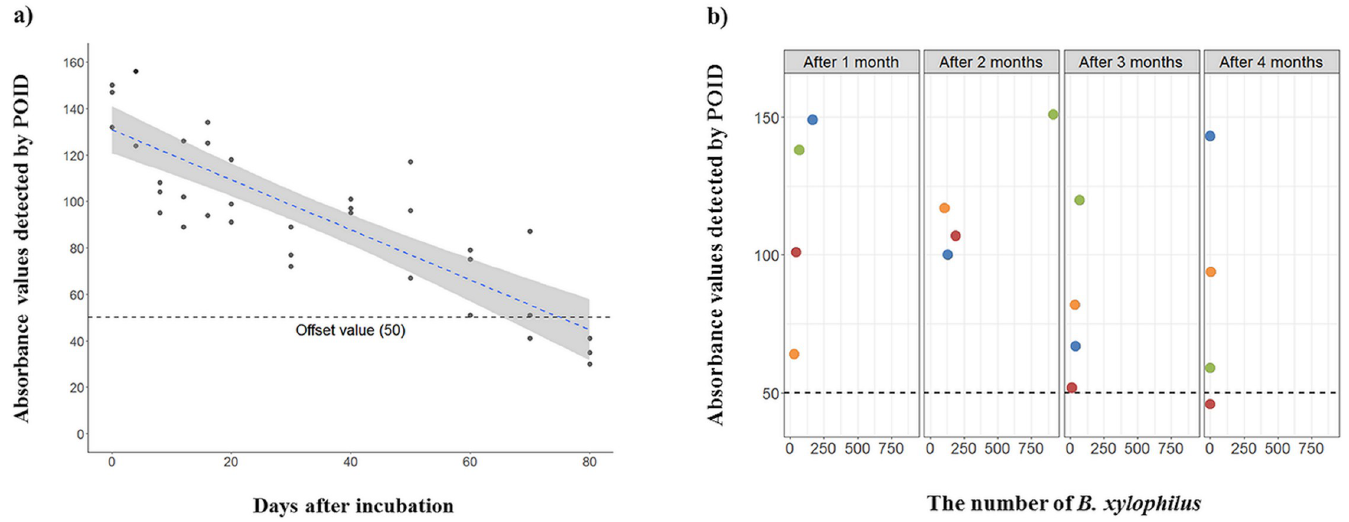
Fig 6. Detection of environmental DNA (eDNA) from B . xylophilus in pinewood logs. a) Summary data of the absorbance values of the RPA assay measured using pinewood logs which were incubated at 50˚C and 40% humidity. The blue dashed line and the grey background represents the regression model line and 95% confidence interval, respectively. b) Evaluation of the RPA assay for the remaining gDNA from B . xylophilus in pine trees placed in natural conditions. The RPA assay was conducted once a month for four months and the number of B . xylophilus per 10 g of pinewood for each log was assessed for every RPA assay. Black dashed lines and colored circles in each panel represent offset values and each log,